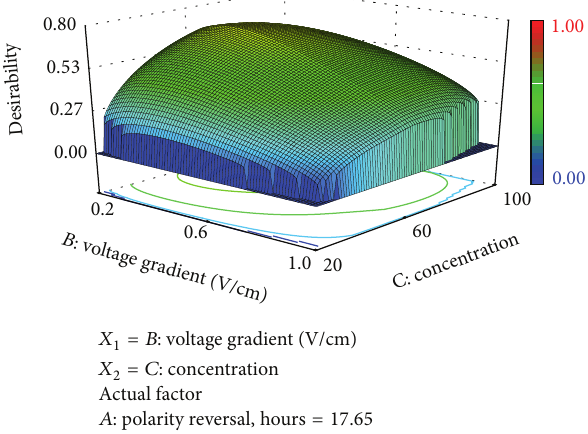
Figure 16: 3D surface plot of the overall desirability variation relative to influential